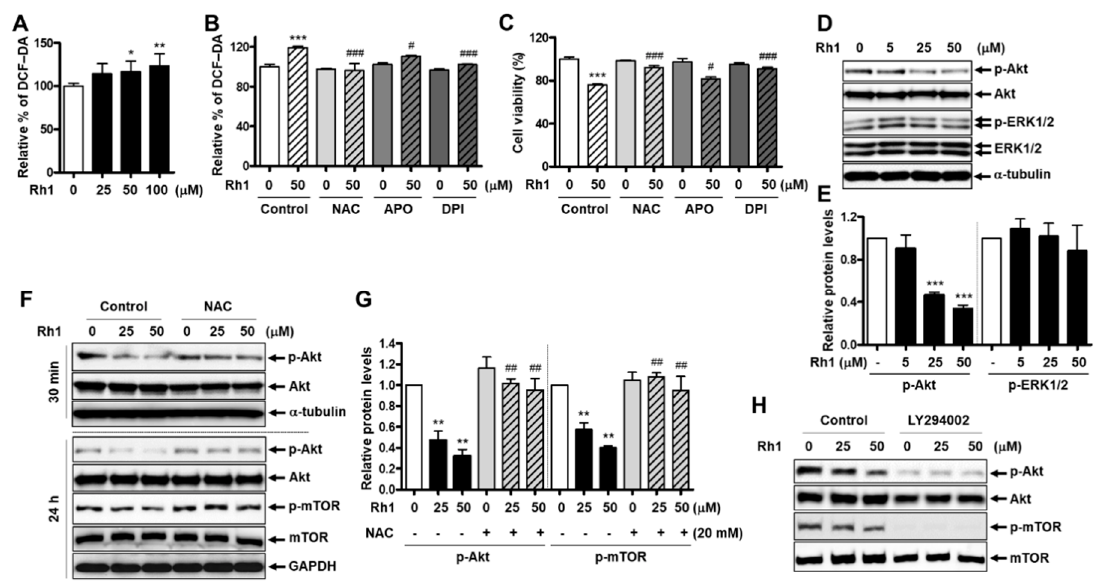
Figure 3. The anticancer effect of Rh1 is associated with the PI3K/Akt pathway and ROS production. ( A ) MCF-7 cells were treated with Rh1 (25 to 100 µM) for 24 h. ROS production was determined using the DCF-DA assay. ( B , C ) MCF-7 cells were pretreated with NAC (20 mM), APO (500 µM), or DPI (250 nM) for 1 h, followed by the treatment with Rh1 (50 µM) for 24 h. ROS production was determined using the DCF-DA assay ( B ). Cell viability was measured by the SRB assay ( C ). ( D , E ) MCF-7 cells were treated with Rh1 at various concentrations for 30 min. The whole-cell lysates were then used to analyze the kinase activity of ERK1/2 and Akt by Western blotting ( D ). The relative quantification of the protein levels was analyzed using Image J software ( E ). ( F , G ) MCF-7 cells were pretreated with NAC (20 mM) for 3 h, followed by the treatment with Rh1 (25 and 50 µM) for 30 min or 24 h. Total cell lysates were subjected to Western blotting. The relative quantification of the protein levels in the experiment with a 24-h treatment of Rh1 was analyzed using Image J software ( G ). ( H ) The cells were pretreated with 5-µM LY294002 for 3 h, followed by the treatment with Rh1 for 24 h. Total cell lysates were subjected to Western blotting. ( A – C , E , G ) Data are expressed as the mean ± SD ( n = 5), * p < 0.05, * * p < 0.01, and ** * p < 0.001 as compared with the control and # p < 0.05, ## p < 0.01, and ### p < 0.001 as compared with the Rh1-treated samples. NAC: N-acetylcysteine, LY294002: PI3K inhibitor, APO: apocynin, and DPI: diphenyleneiodonium.